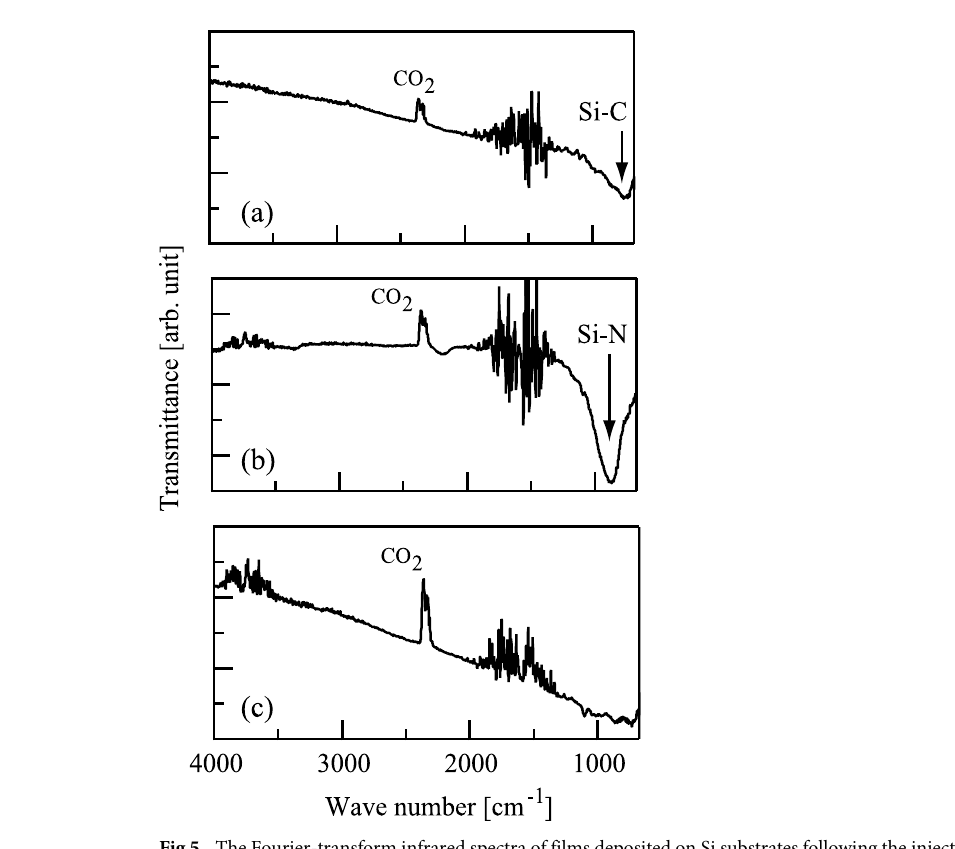
Fig 5. The Fourier-transform infrared spectra of films deposited on Si substrates following the injection of (a) Ar + and (b) N + ions in conjunction with hexamethyldisilazane. (c) The Fourier-transform infrared spectrum of a sample on a Si substrate following the supply of hexamethyldisilazane without ion beam irradiation. Substrate temperature during the deposition experiments was 540 ˚C. The duration of the deposition experiments was